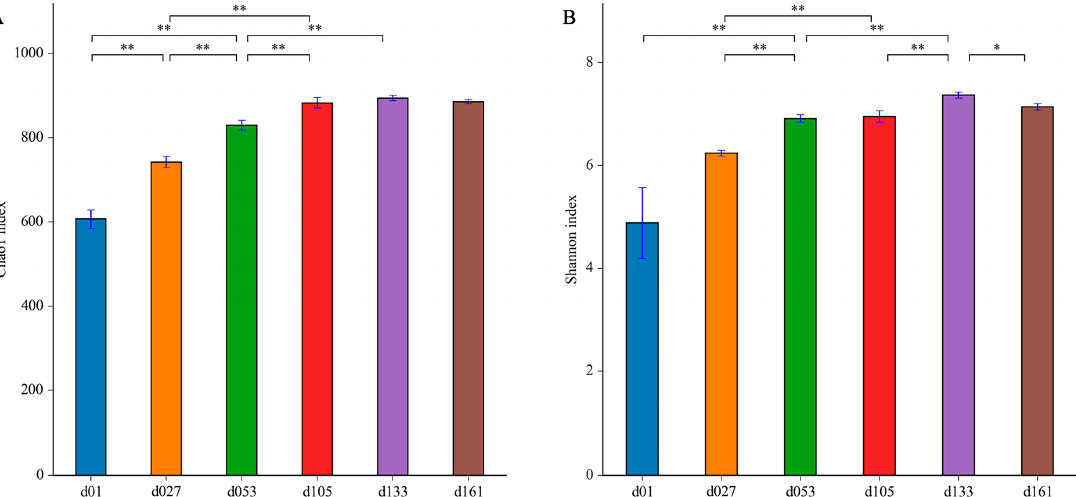
Figure 2. Dynamic changes of cecal microbiota alpha diversity with age in Wenchang chickens. ( A ) Chao1 index; ( B ) Shannon index. Different letters represent significant differences in alpha diversity indices based on Student’s t -test (* p < 0.05, ** p < 0.01). d01, n = 12; d027, n = 11; d053, n = 12; d0105, n = 12; d133, n = 12; d161, n = 12.